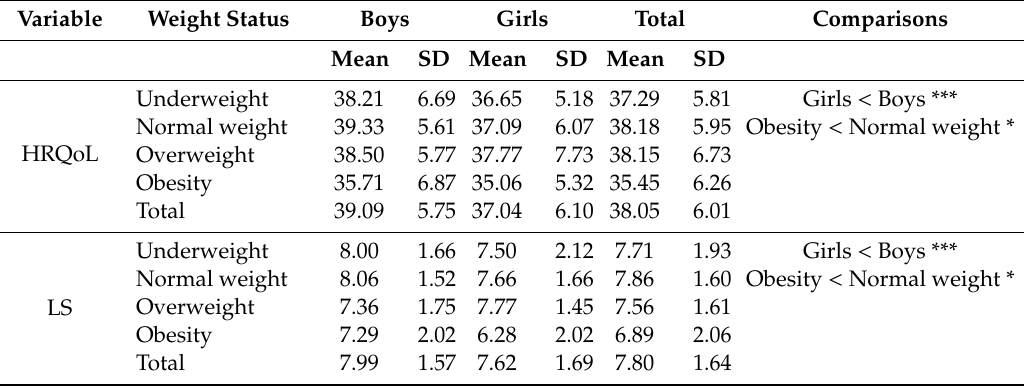
Table 3. Health-related quality of life (HRQoL) and life satisfaction (LS) based on gender and weight status of the